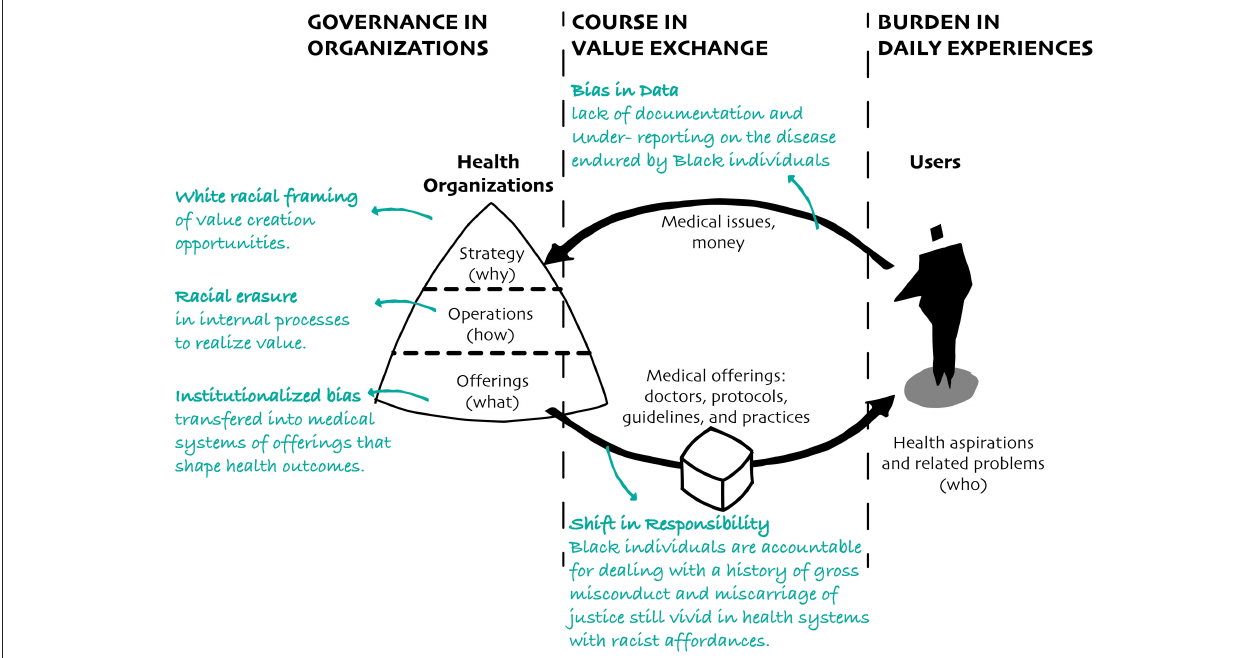
FIGURE 3 | Health organizations create systems of offerings based on the information available to them. Because they lack proper documentation on diseases endured by Black populations, they transfer racial bias into medical offerings that shape the experiences and health outcomes of Black